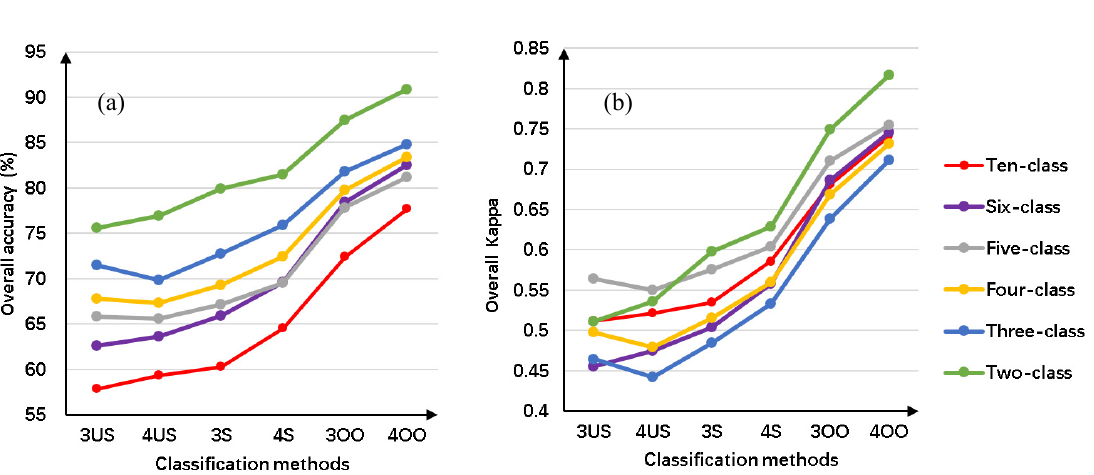
Figure 10. Overall accuracy ( a ) and overall kappa ( b ) for six class groupings based on six classification types. Classification methods were represented as unsupervised classification for three-band image (3US), unsupervised classification for four-band image (4US), supervised classification for three-band image (3S), supervised classification for four-band image (4S), object-based classification for three-band image (3OB), and object-based classification for four-band image (4OB).